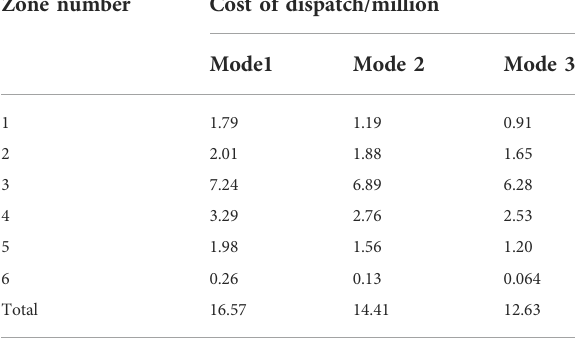
TABLE 3 Dispatching costs of the three control